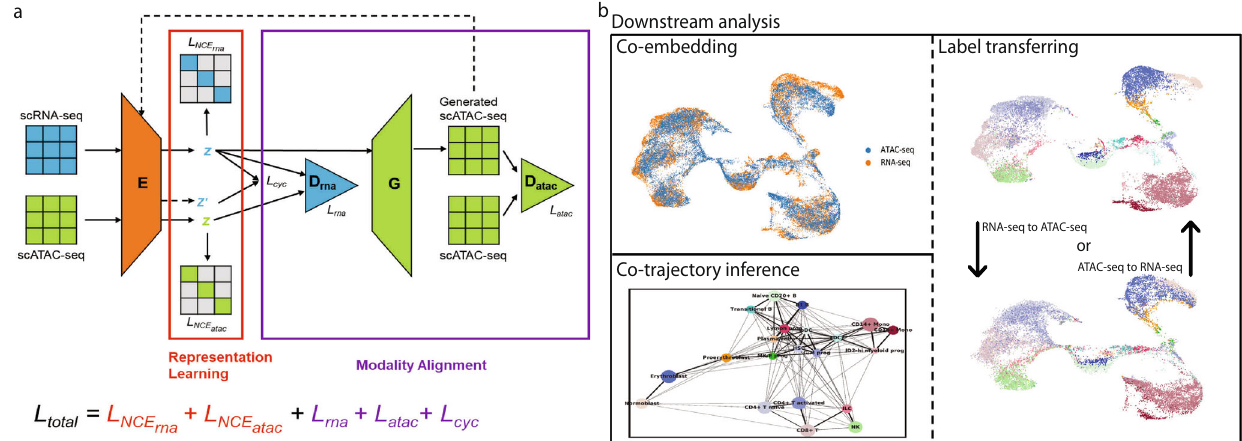
Fig. 1 Overview of sciCAN and potential applications. a sciCAN model architecture. sciCAN contains two major components: representation learning and modality alignment. The representation learning part of the model is highlighted in the red box, and the modality alignment part in the purple box. Inputs of scATAC-seq and scRNA-seq have been preprocessed to have the same feature dimensions, so they can share one single encoder E . The fi nal total loss ( L ) is the sum of loss of representation learning in red and loss of modality alignment in purple. Of note, calculation of NCE is independent for scATAC-seq and scRNA-seq data. b Downstream integrative analyses can include but are not limited to co-embedding, co-trajectory, and label